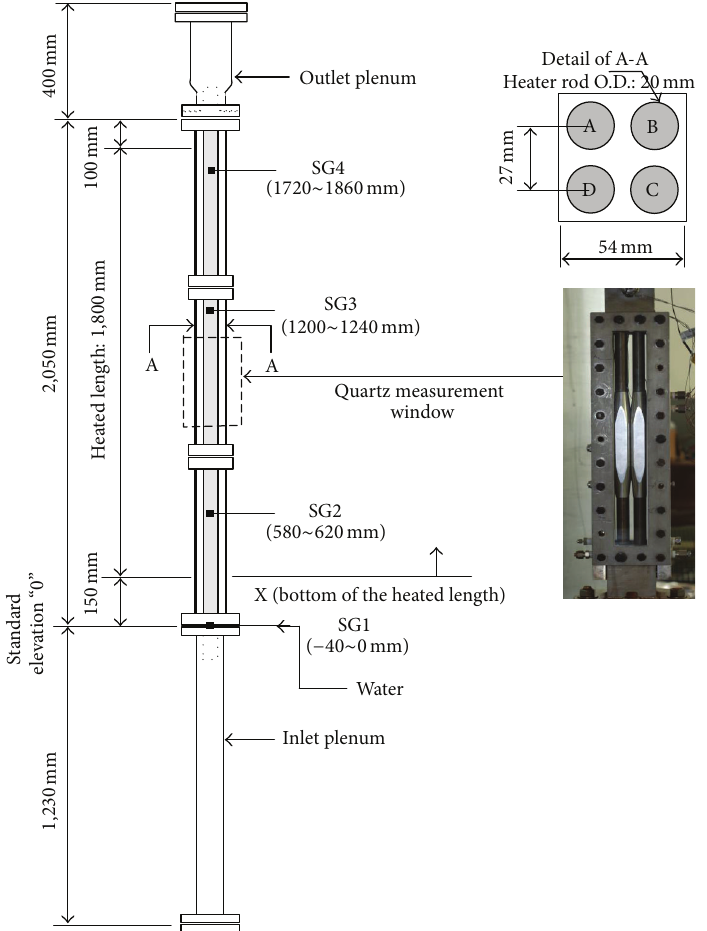
Figure 1: Schematic diagram of the test section in the 2 × 2 test